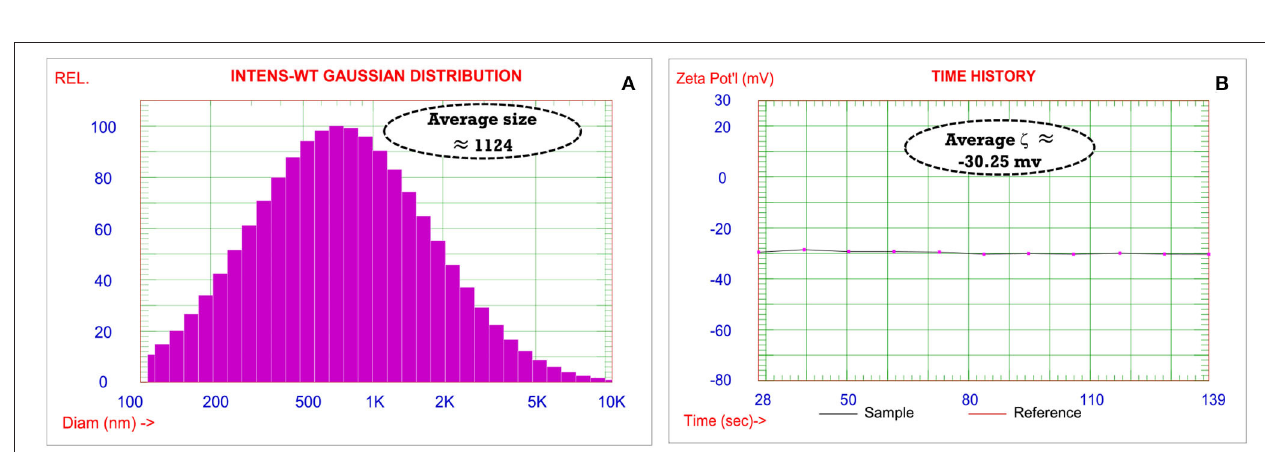
FIGURE 3 | (A) analysis of particle size (B) zeta potential of the commercial Zn